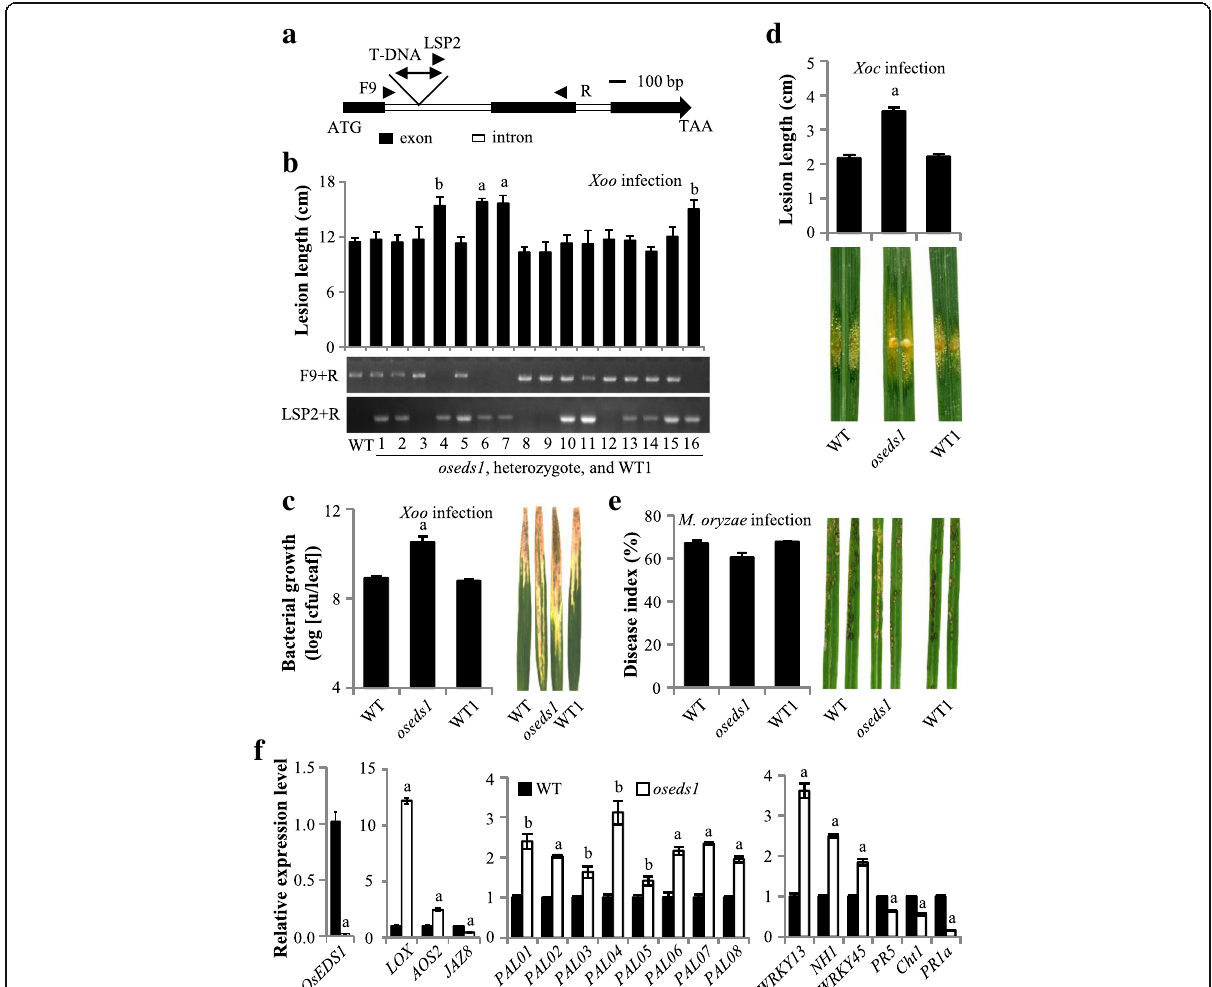
Fig. 2 The increased susceptibility of oseds1 mutant to X. oryzae was associated with insertion of T-DNA. Two-tail student ’ s t-test . The “ a ” and “ b ” above bar indicate significant differences between wild-type (WT) and oseds1 plants at P < 0.01 and P < 0.05, respectively. a T-DNA insertion site in oseds1 mutant. T-DNA was inserted at position 587 of OsEDS1 , counting the first nucleotide of translation start codon (ATG) as 1. TAA, translation stop codon. Arrows were PCR primers used for examination of the mutant. F9+R, OsEDS1 primers; LSP2+R, T-DNA, and OsEDS1 primers. b Homozygous oseds1 mutant was more susceptible to Xoo than heterozygotes and WT siblings (WT1). Data represent mean±SE ( n =4 to 5). Plants 4, 6, 7 and 16 were homozygous oseds1 mutants, 1, 2, 5, 10, 11, 13, 14 and 15 were heterozygotes, and 3, 8, 9, and 12 were WT1. c Bacterial growth was analyzed at 12days and disease symptoms at 14days after Xoo infection. Data represent mean±SE ( n =3). d oseds1 was more susceptible to Xoc . Lesion length and disease symptom were analyzed at seven days after Xoc infection. Data represent mean±SE ( n =10 to 15). e oseds1 had a similar level of susceptibility to M. oryzae to that of WT plants. Disease index and disease symptom were analyzed at seven days after X. oryzae infection. Data represent mean±SE ( n =23 to 28). f oseds1 affected a set of defense-related genes expression. Data represent mean±SE ( n